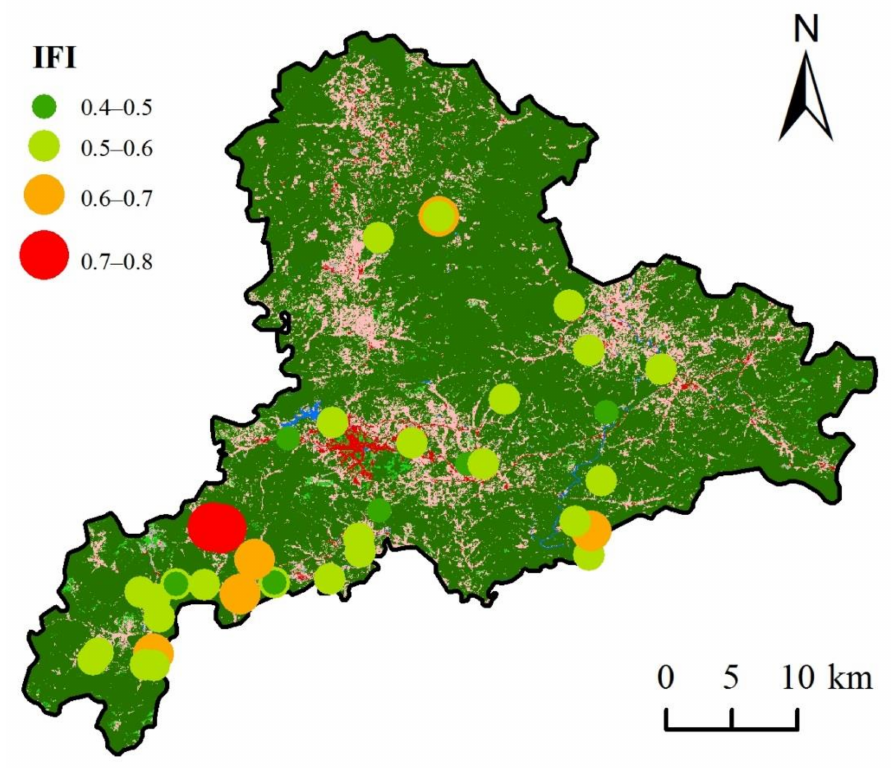
Figure 4. Spatial distribution of integrated fertility index (IFI) in the study